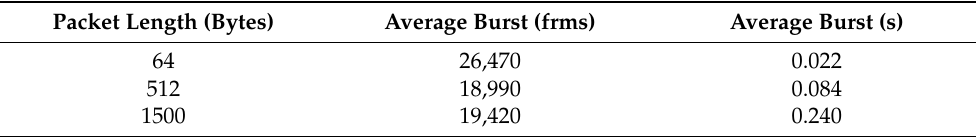
Table 4. Maximal lossless packet transmission rate (back-to-back